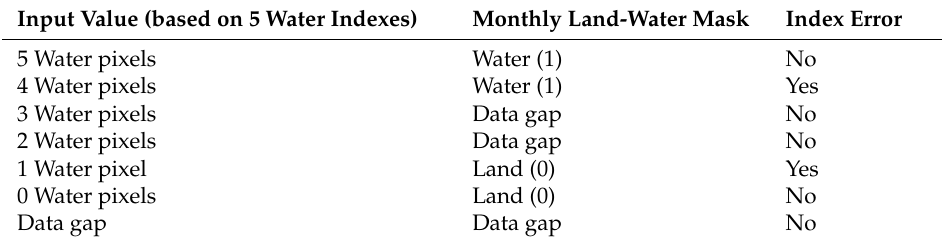
Table 3. Look up table for creation of final land-water mask and index error based on 5 water indexes.